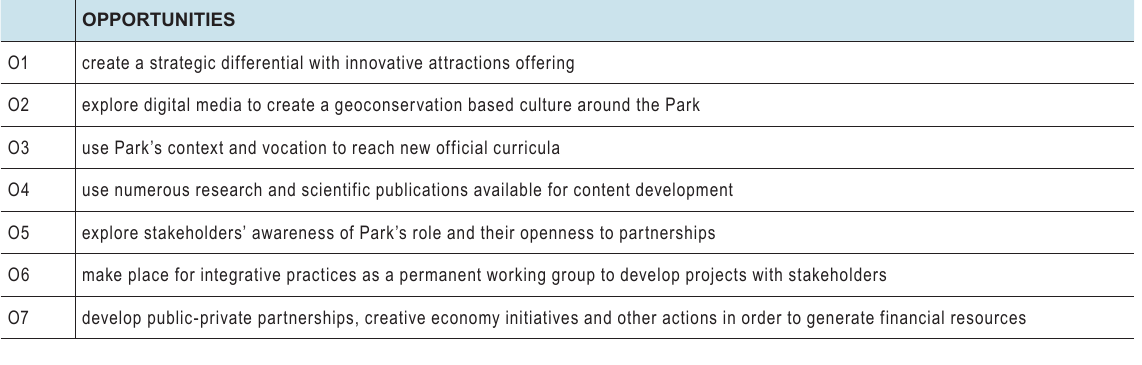
TABLE 9 . SWOT Matrix Quadrant 4: Threats.